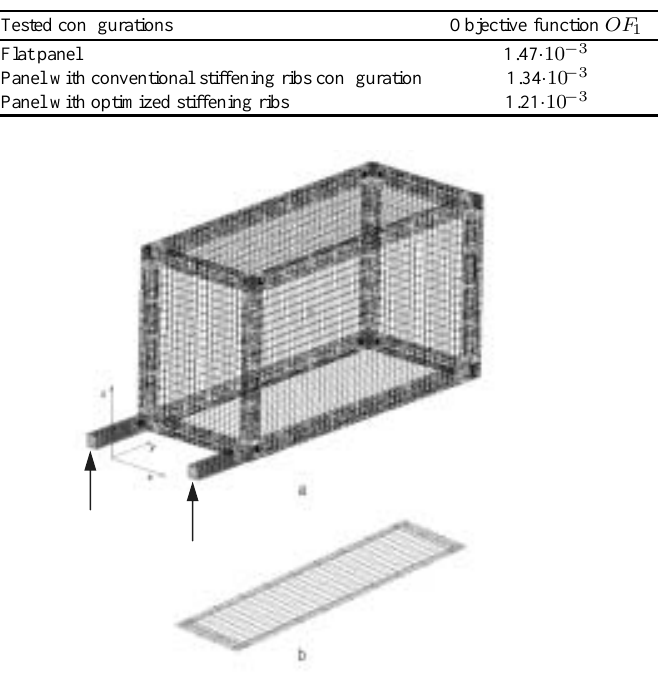
Fig. 5. Structure division according to the superelement technique. Floor-less box structure (a); panel undergoing optimization (b) The load forces are also shown.